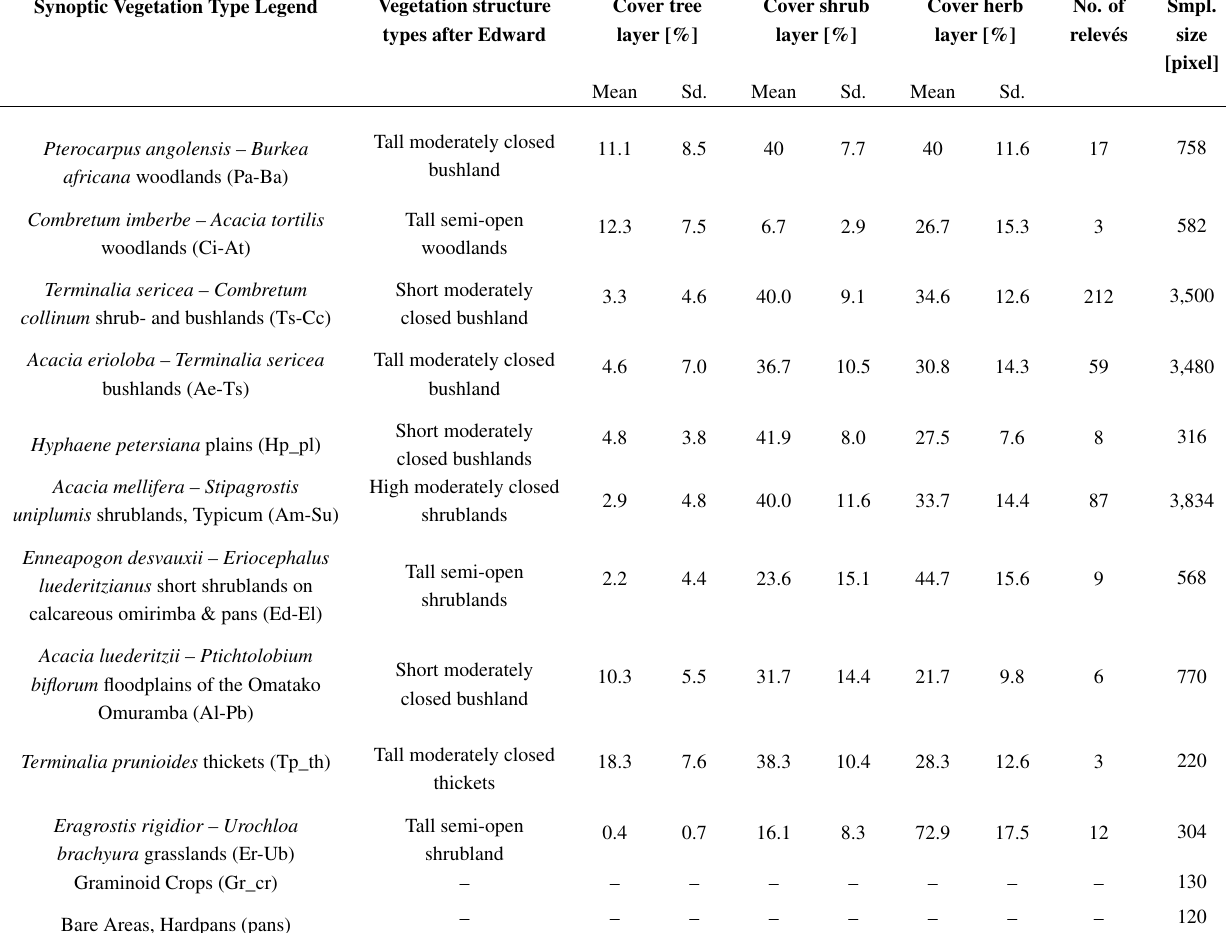
Table 1. Synoptic vegetation type legend showing the ten vegetation types synthetised from the phyto-sociological analysis. The structural vegetation type classes after Edwards [41] as well as mean and standard deviation (Sd) of the cover of tree, shrub and herbaceous layer as sampled in the field indicate slight differences in the life form composition. Note the variances of relevé numbers due to limited accessibility and the extended sample size after the merge process with image objects from the segmentation of Landsat